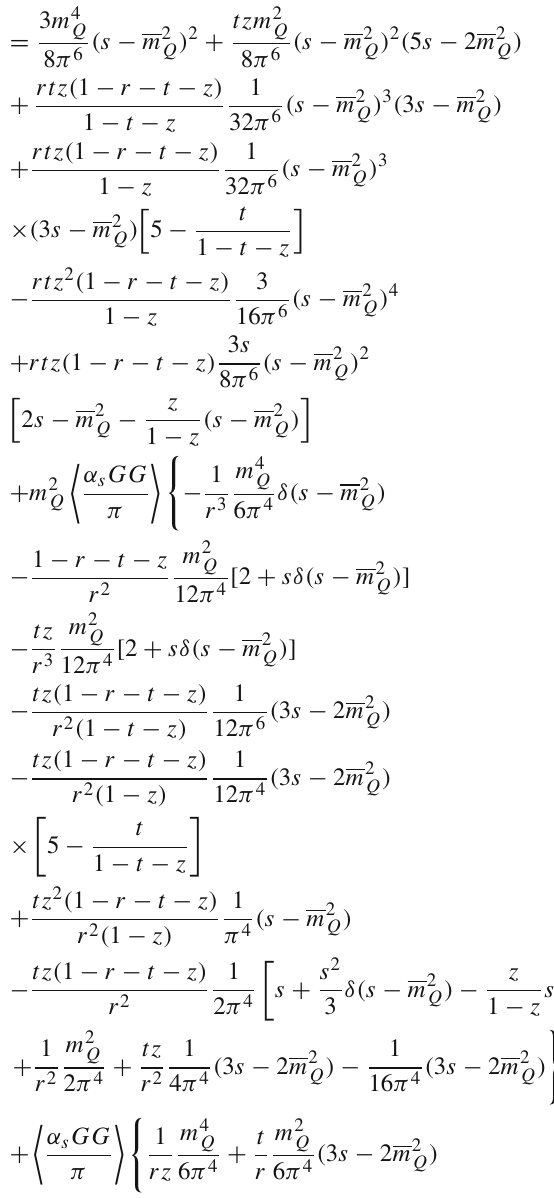
Fig. 9 The residue λ X ( cc ¯ c ¯ c , 0 ++ ) with variation of the energy scale μ from Eqs. (29, 30)